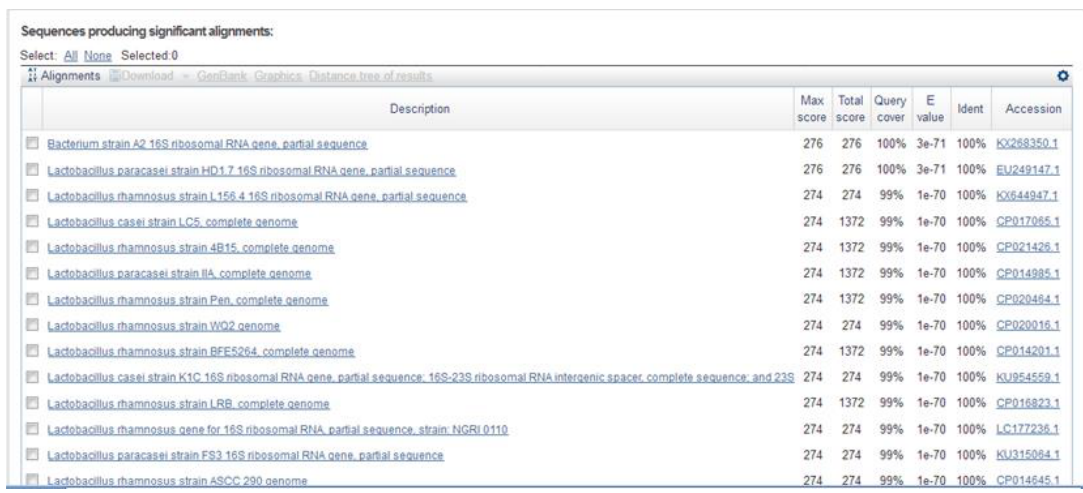
Figure 3. Lactid acid bacteria gene sequence from isolation of Lactobacillus plantarum .